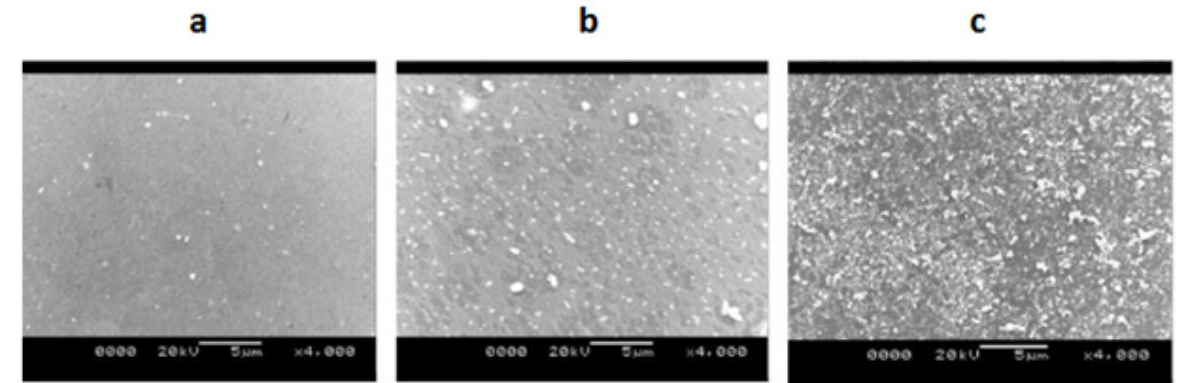
Figure 1 - Representative SEM images of the a ) mPE, b ) mPE-2.5 J/cm 2 and c ) mPE-5 J/cm 2 treated